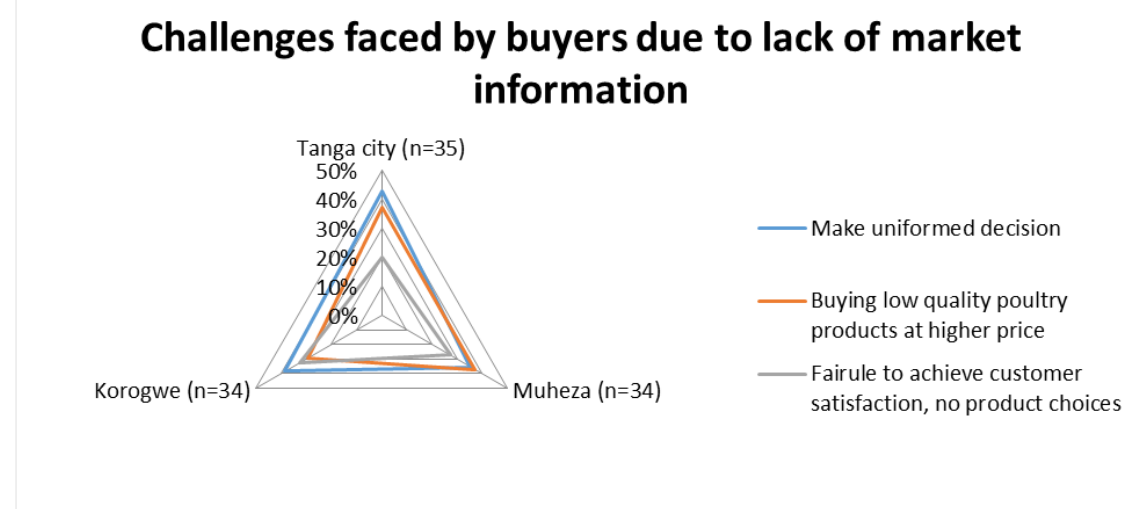
Figure 4. Description of challenges faced by poultry buyers due to lack of market information, 2018